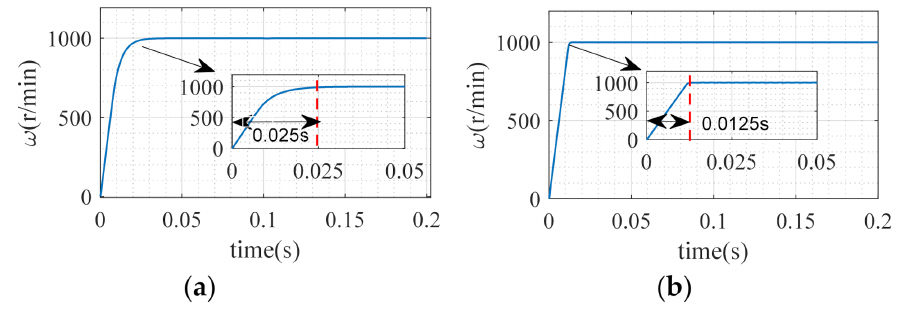
Figure 3. Speed response: ( a ) SMC system with the FPRL; ( b ) SMC system with the IPRL.